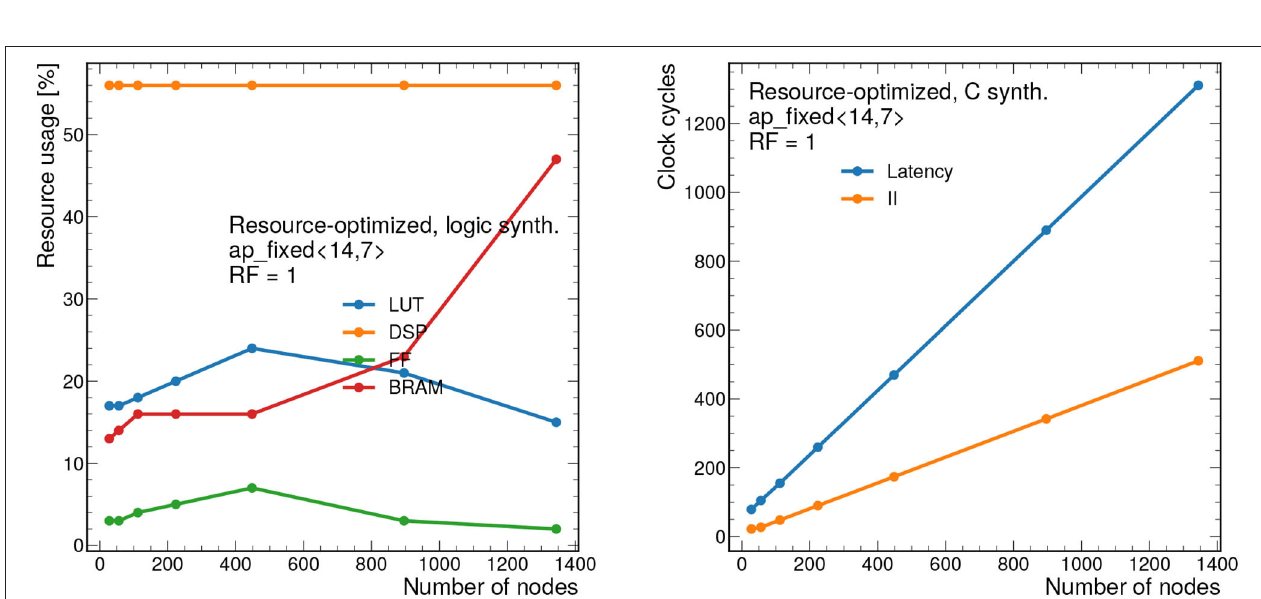
FIGURE 13 | Resource usage estimates as a percentage after logic synthesis (left) and latency and II in clock cycles (right) for a constant reuse factor of 1 and a bit width of ap_fixed<14,7> as a function of the number of nodes n nodes . The number of edges is fixed to n edges graphs. Each clock cycle corresponds to